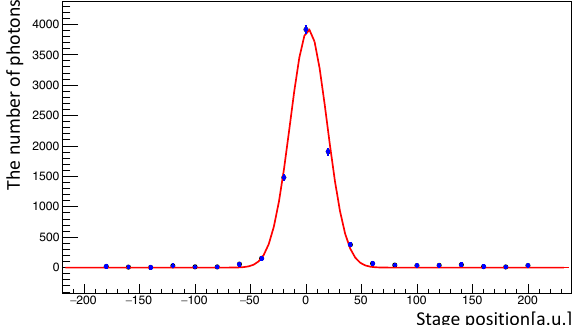
Figure 5. Observed number of FWM photons as a function of stage position in the delay line for a fine timing tuning between two creation laser pulses when a thin BBO crystal was positioned at